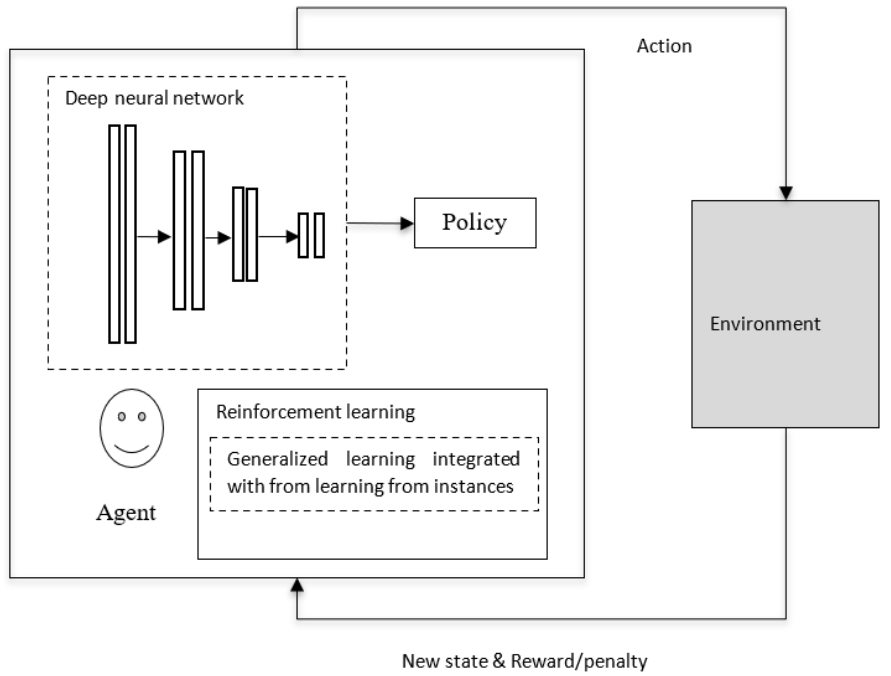
Figure 6. Deep reinforcement learning in AI: DNN-driven policy and neuro-inspired generalized learning integrated into learning from instances.